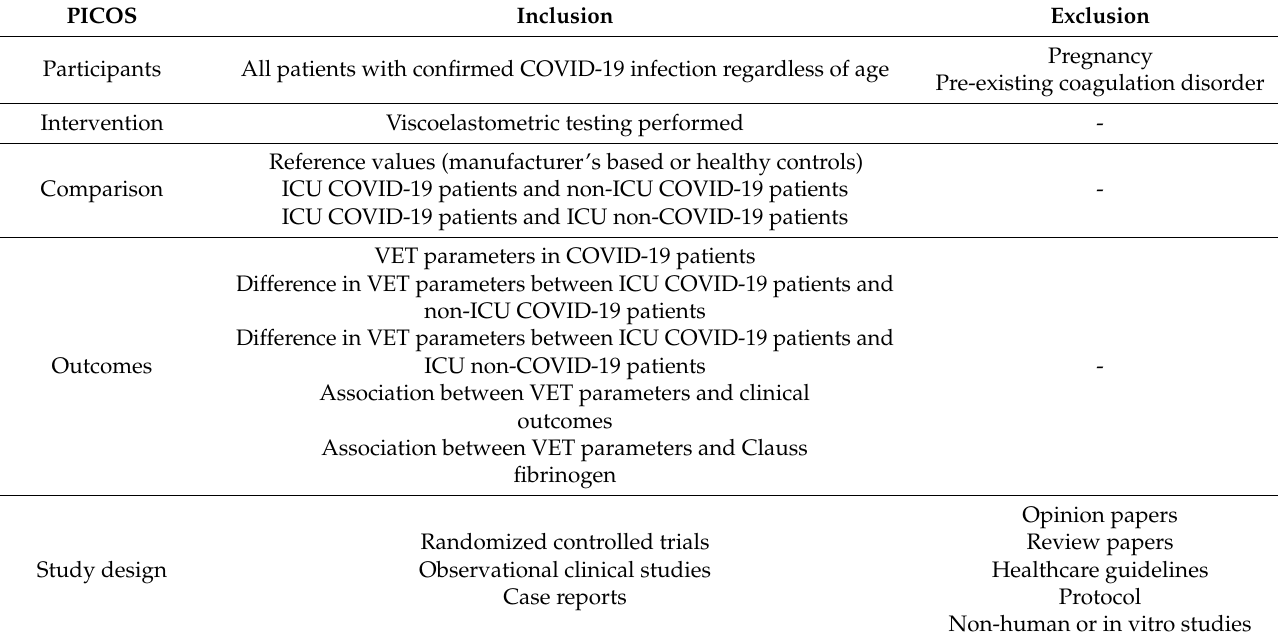
Table 1. Eligibility